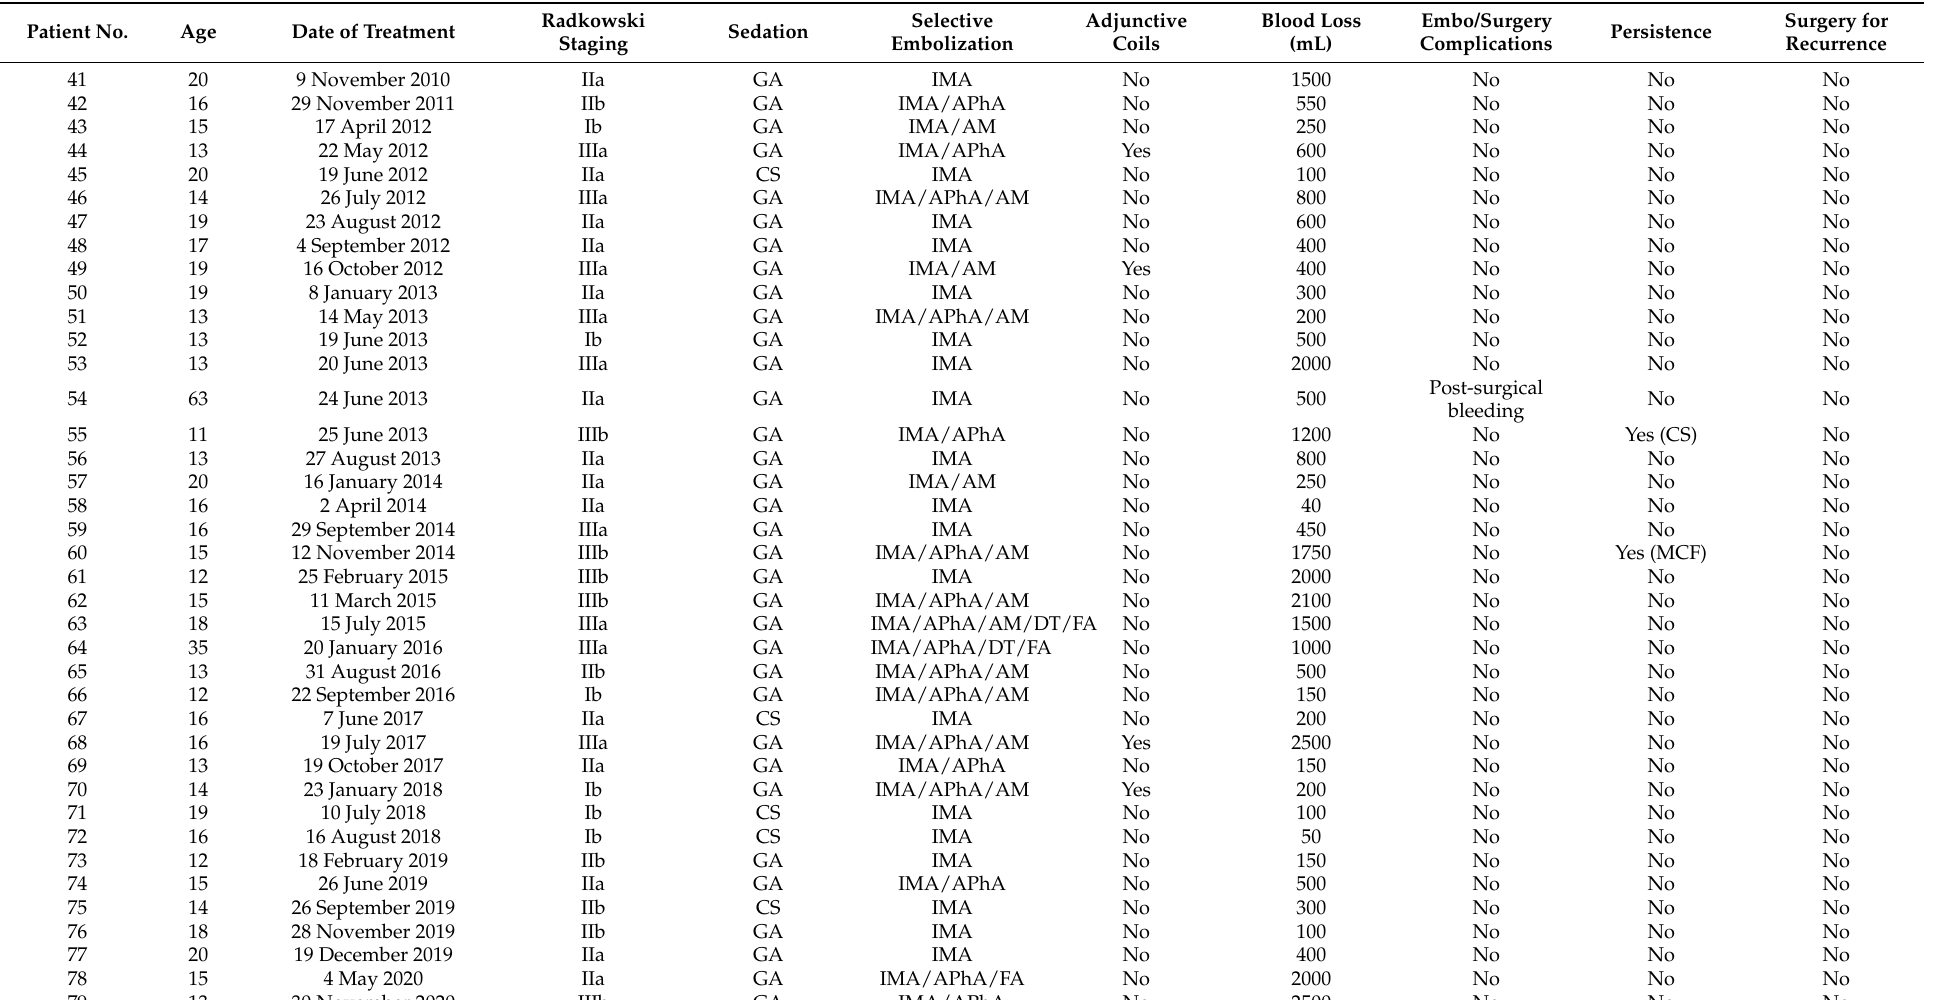
GA IMA/APhA No 2500 No No No CS: cavernous sinus; PPF: pterygopalatine fossa; MCF: middle cranial fossa; GA: general anesthesia; CS: conscious sedation; IMA: internal maxillary artery; APhA: ascending pharyngeal artery; DT: deep temporal branch of MMA; AM: accessory meningeal branch of MMA; FA: facial